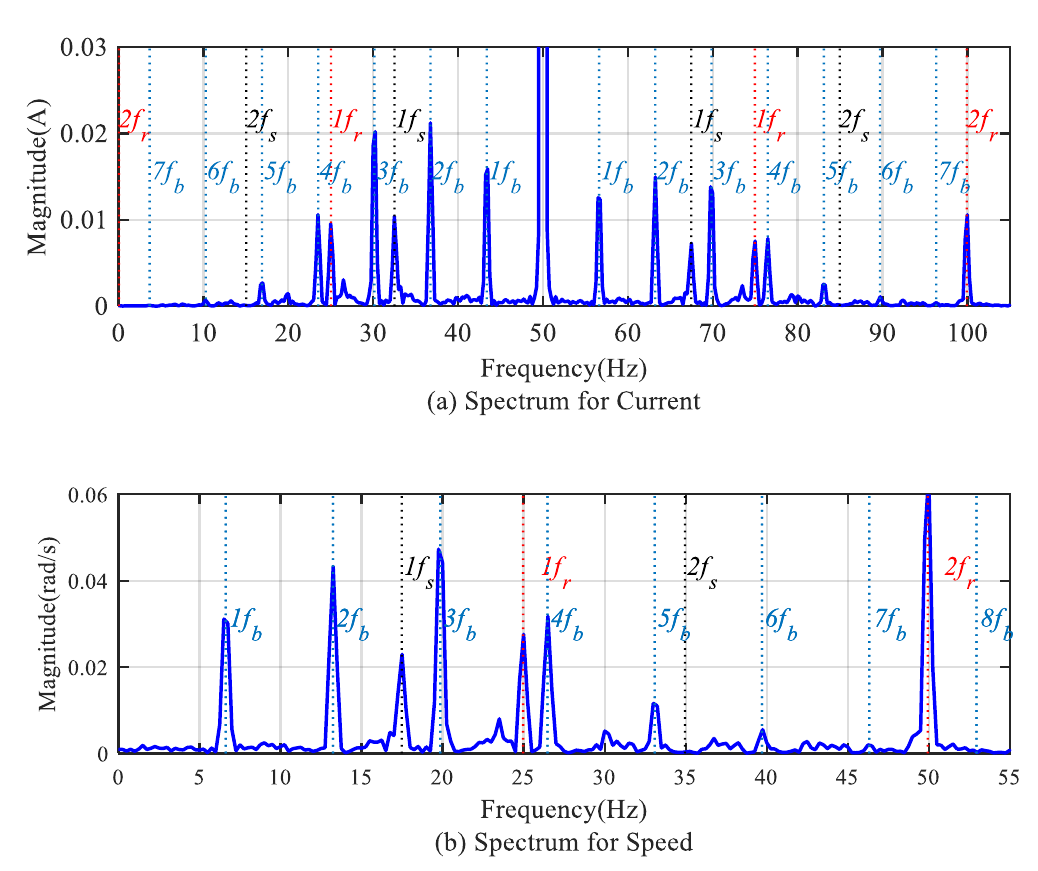
(b) Spectrum for Speed Figure 12. Spectra of current and speed ( 𝑃 0 = 260 N). Figure 12. Spectra of current and speed ( P Figure 12. Spectra of current and speed ( 𝑃 (cid:2868) = 260 N). 0 = 260